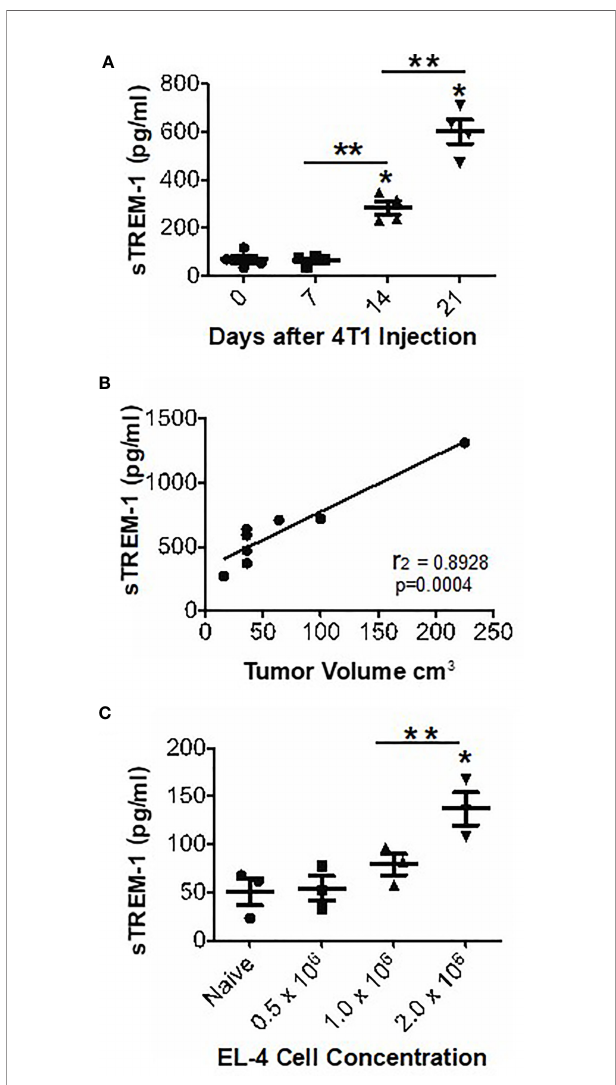
FIGURE 4 | sTREM-1 levels are increased in the plasma of tumor-bearing mice and correlate with tumor burden. (A, B) The mice were injected with 10 4 4T1 cells or with varying concentrations of EL-4 thymoma cells (C) . The plasma sTrem-1 levels and tumor burden were assessed at various time points (A, B) or at 2 weeks after injection (C) . The sTREM-1 levels were determined by ELISA. * p -value <0.05 relative to naïve mice, ** p -value <0.01 (A, C) . Linear regression analysis was performed to obtain an r 2 value of 0.8928 and a p-value of 0.0004 (B)